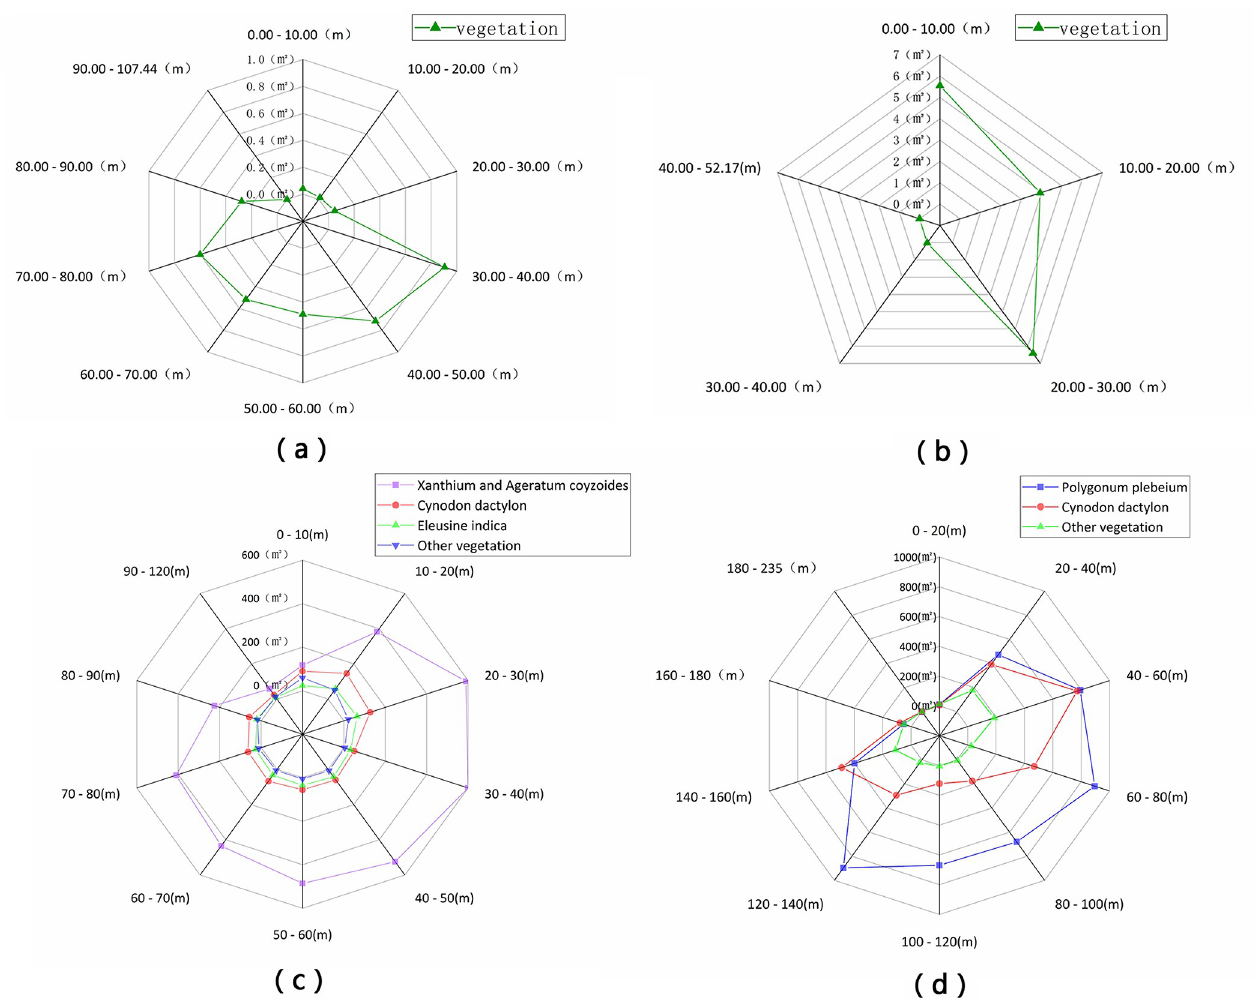
Fig 8. Vegetation distributions as a function of distance to the nearest water body in the WLFZ of (a) Huangdeng study area 1, (b) Huangdeng study area 2, the (c) Nuozhadu study area, and the (d) Xiaowan study